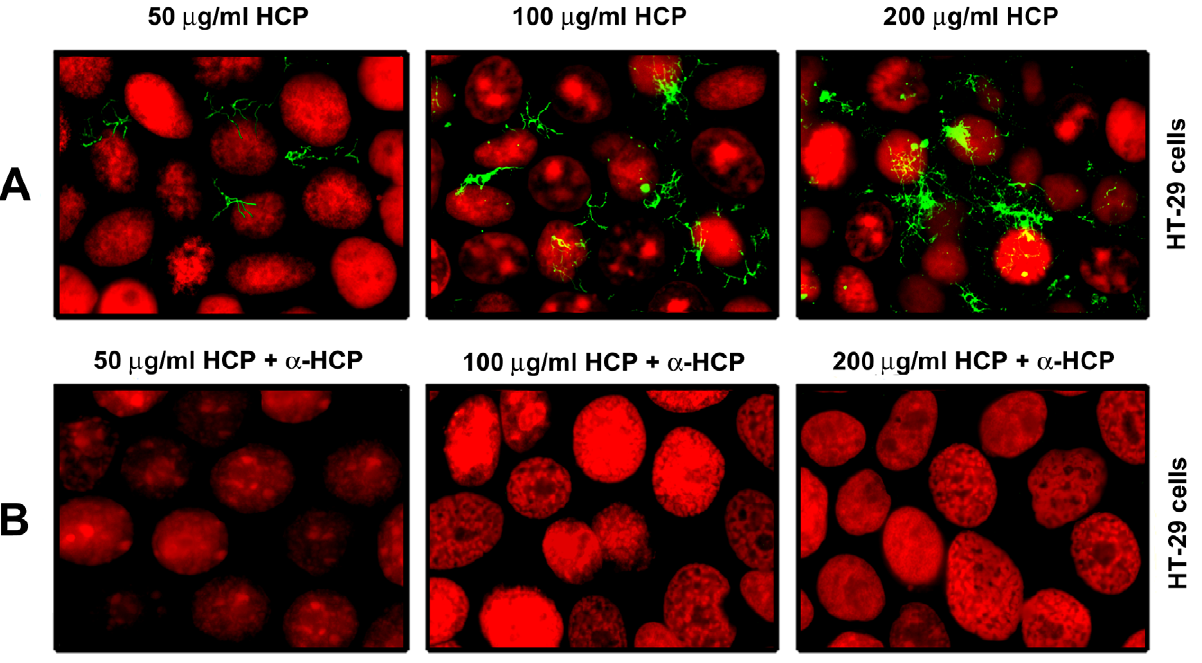
Figure 3. Binding properties of HCP to HT-29 cells. HCP used at 50, 100, and 200 m g/ml were incubated with polarized HT-29 cells, washed, and then visualized by IFM (A). Inhibition of HCP binding using a 1:100 dilution of anti-HCP antibodies (B). The nucleus was labeled with propidium iodide (red) and HCP with Alexa Flour 488 (green). The images were taken at 200 6 .